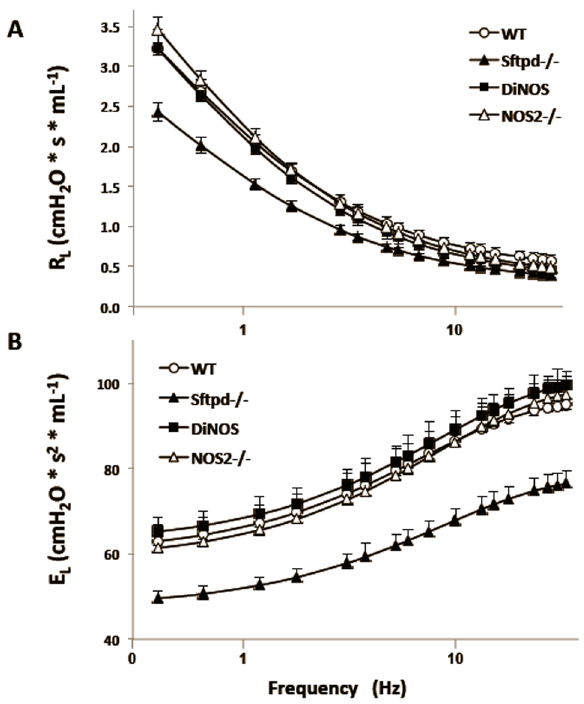
Figure 6. NOS2 ablation corrects lung resistance and elastance changes seen in Sftpd 2 / 2 mice. Lung resistance ( A ) and elastance ( B # ) spectra as a function of frequency, at a positive end-expiratory pressure (PEEP) of 3 cm H 2 O, are shown. Each point represents the mean of 3–6 measurements 6 S.E., lines are the empirical fit [28] using the model outlined in the Online Supplement. Sftpd 2 / 2 spectra are significantly different from WT as determined by x 2 test (p , 0.05).